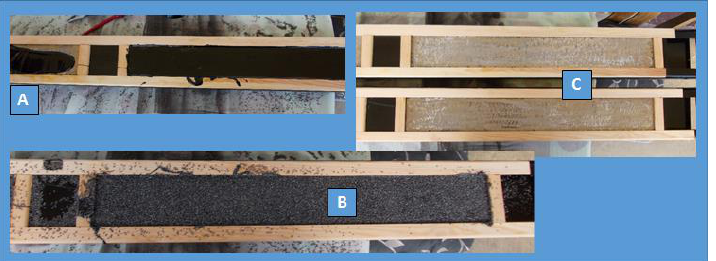
Figure 12. Technology of the anti-slip layer: ( A ) — Mould for casting the elastomer; ( B ) — Covering the elastomer with corundum; ( C ) — Mould for casting the